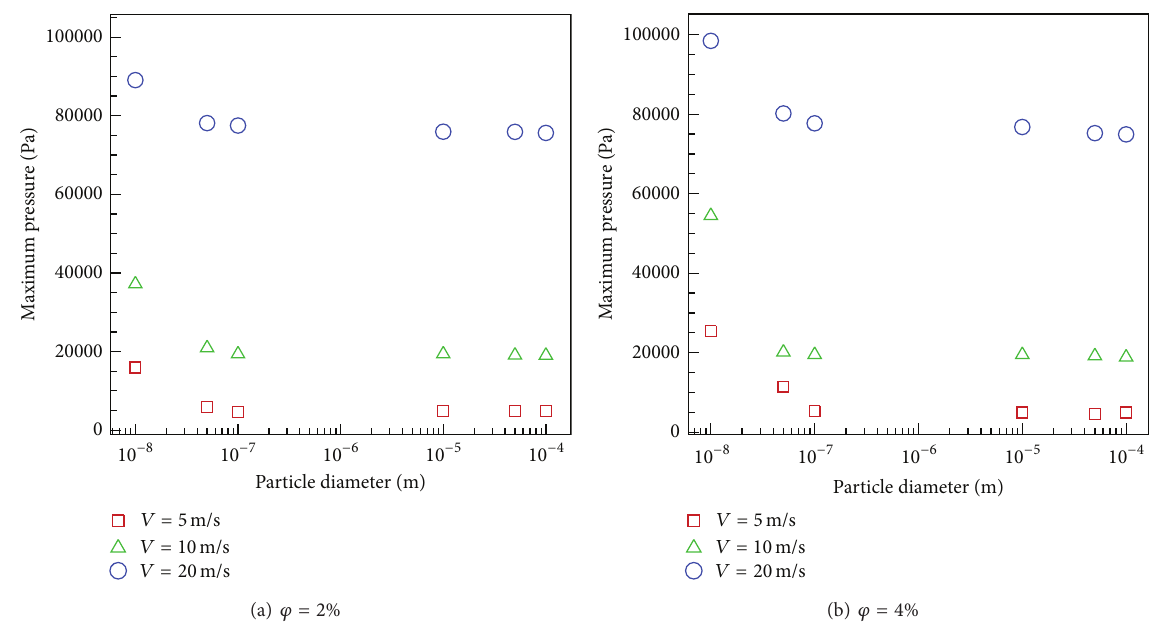
Figure 8: The variation of particle size with maximum pressure.